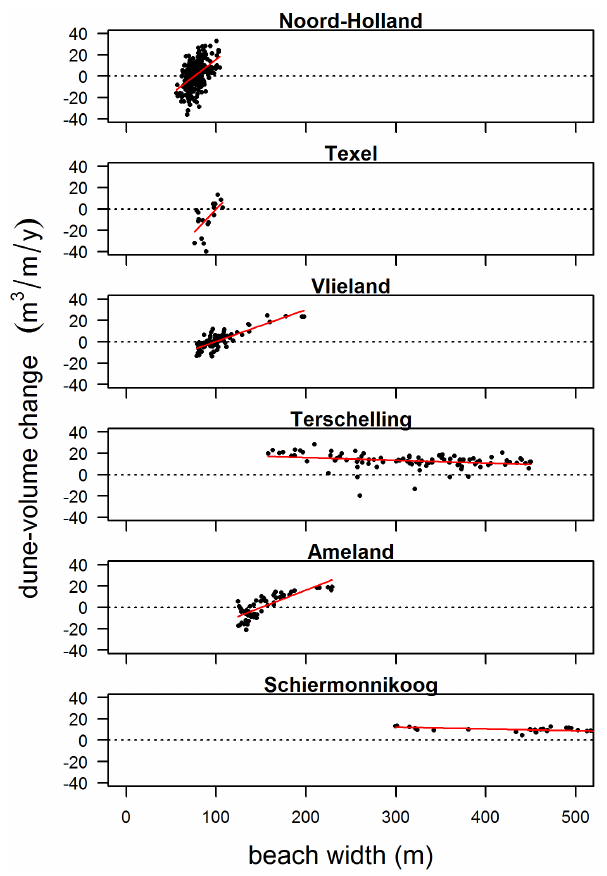
Figure 11. Decadal dune-volume changes ( D V) as a function of 10-y-averaged beach width (W). Red line indicates least-squares linear fit. All correlations are significant at the p , 0.05 level. Values representing a profile with nourishment activity within the specific decade were discarded.